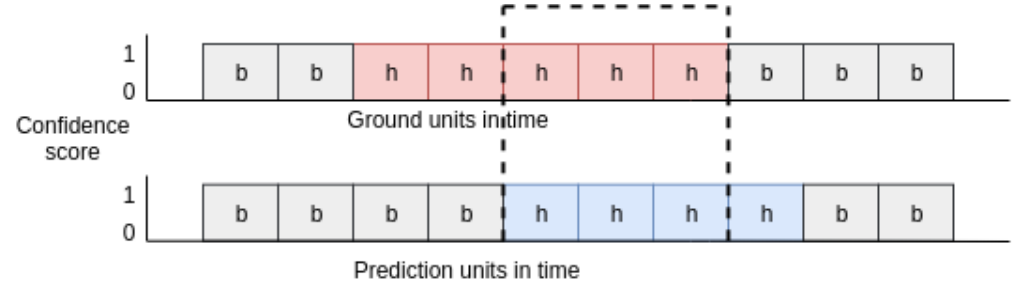
Figure 5. Unit-level prediction. Top : ground truth labels. Bottom : prediction results. Each rectangle represents consecutive 30